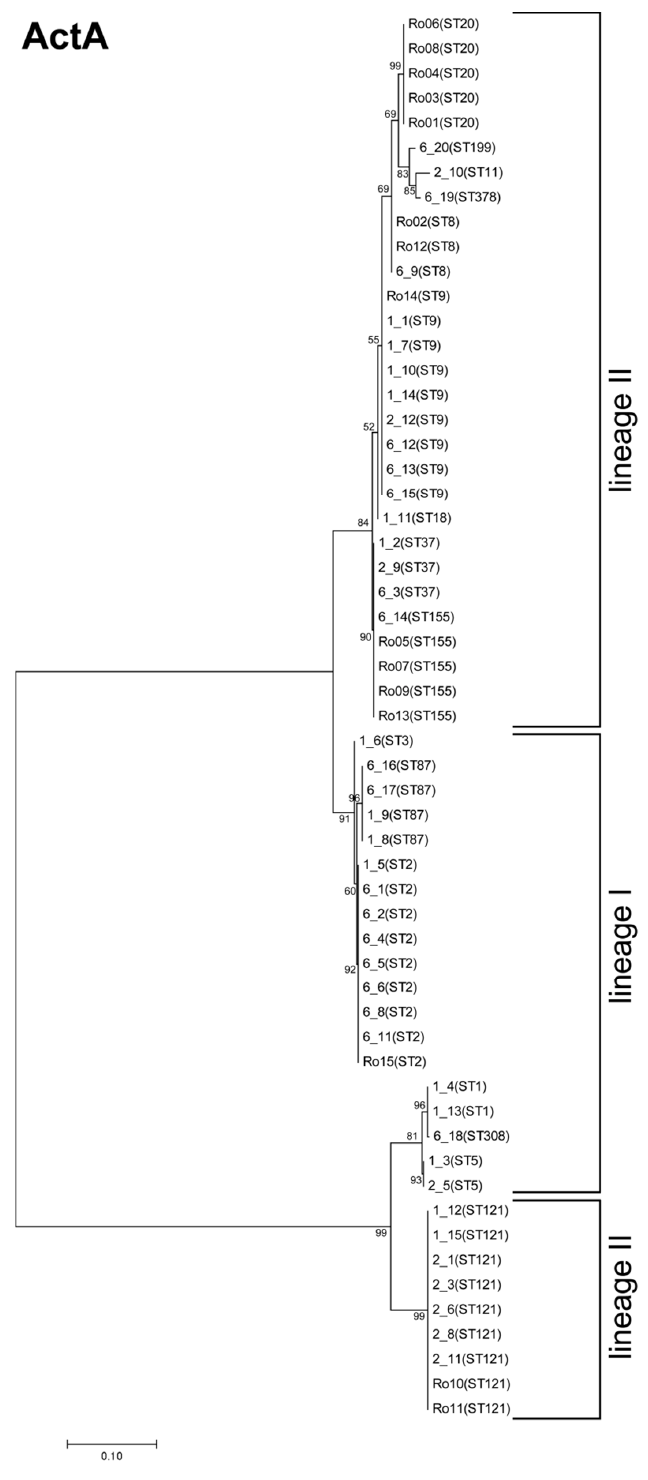
Figure 7. Phylogenetic analysis of ActA. Molecular phylogenetic analysis, based on the maximum likelihood method using ActA sequence, was calculated with MEGA7 using the JTT matrix-based model [22,26]. The tree is drawn to scale, with branch lengths measured by the number of substitutions per site. Bootstrap values (100× resampling) are indicated at the respective nodes. The analysis involved 57 amino acid sequences. All positions with less than 75% site coverage were eliminated resulting in 633 positions in the final dataset.